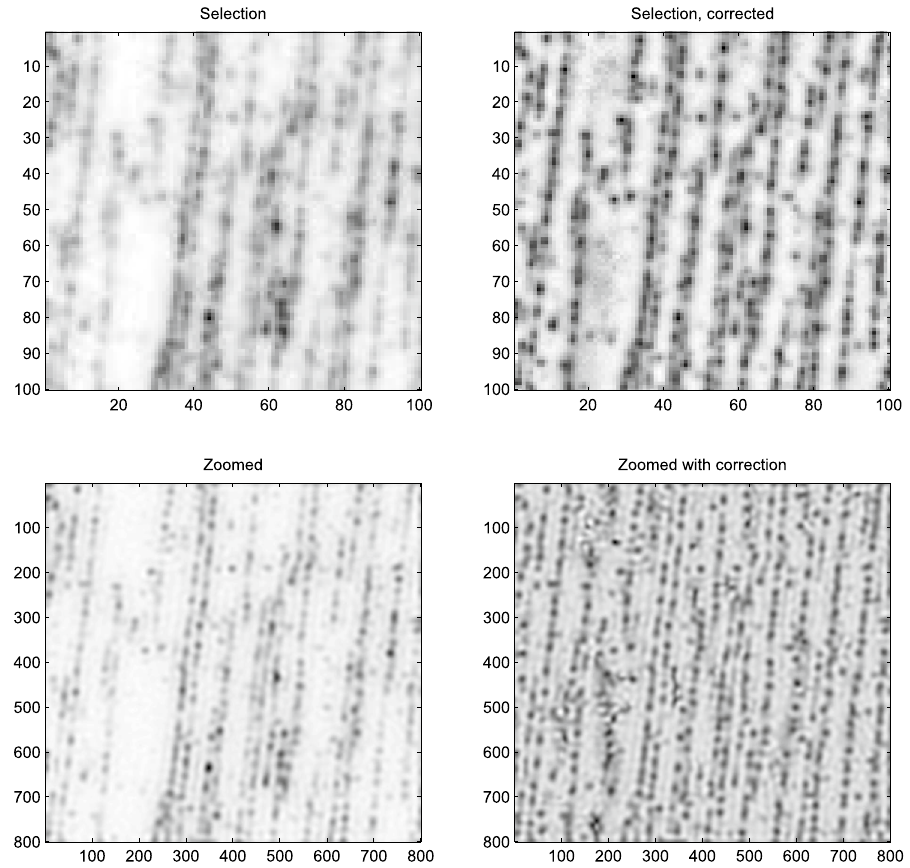
Figure 10. Contrast enhancement with asymmetric smoothing, applied to the DNA image. Upper-left panel: a section of the original image. Upper-right panel: idem, after enhancement. Lower-left panel: zoomed section of the original image. Lower-right panel: idem, after enhancement.